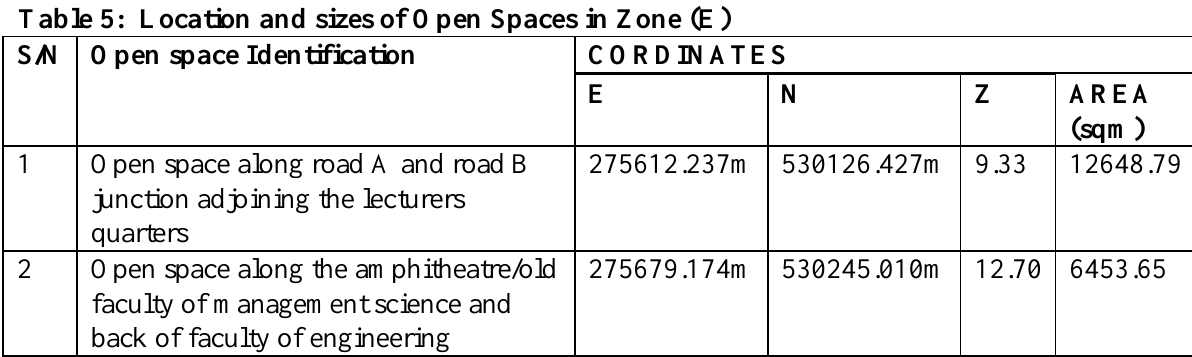
In zone E, Open space along the amphitheatre/old faculty of management science and back of faculty of engineering is the largest vacant space within the zone with a total area of